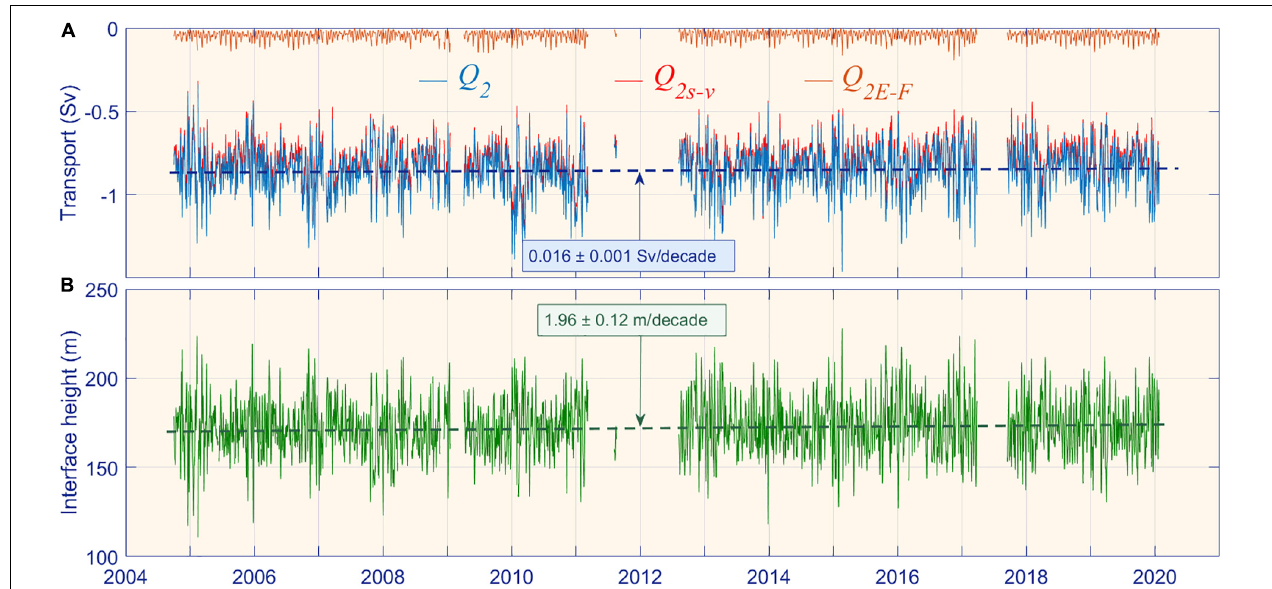
FIGURE 6 | (A) Total outflow Q 2 at Espartel section computed from the available velocity profiles (blue line), and the slowly varying Q 2 s − ν (red line) and eddy-fluxes Q 2 E − F (sienna line) contributions (see text for details). Deep-blue dashed line is the linear trend in the whole period. (B) Interface height h 2 at the position of the monitoring station and its linear trend (dashed-green line). All series have been filtered to remove tidal variability so that the marked fluctuations in both panels reflect subinertial and seasonal